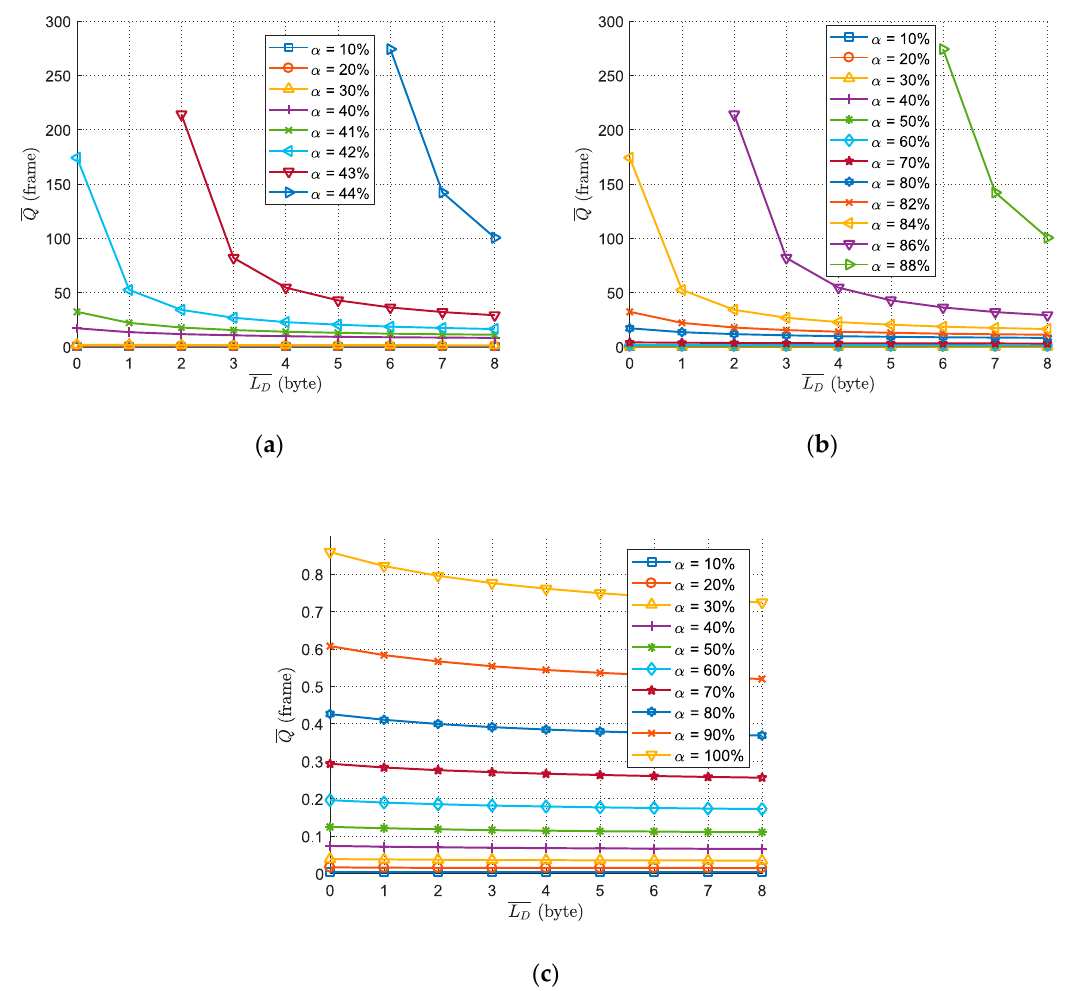
Figure 13. Relationship between average RX queue length Q and average length of data L D with a given CAN bus load α and UART baud rates R o . ( a ) 115,200 baud, ( b ) 230,400 baud, ( c ) 460,800 baud.